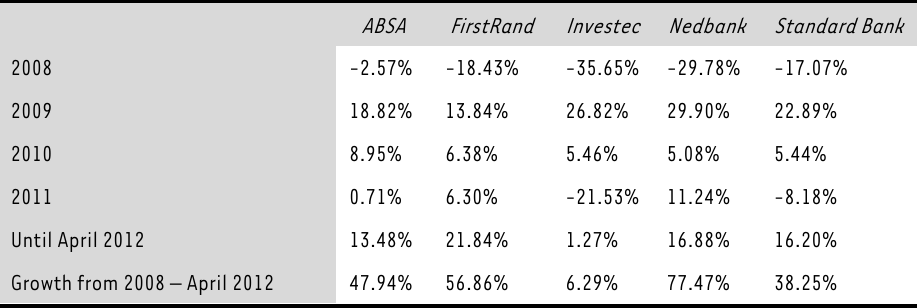
TABLE 6: Summary of yearly returns ABSA FirstRand Investec Nedbank Standard